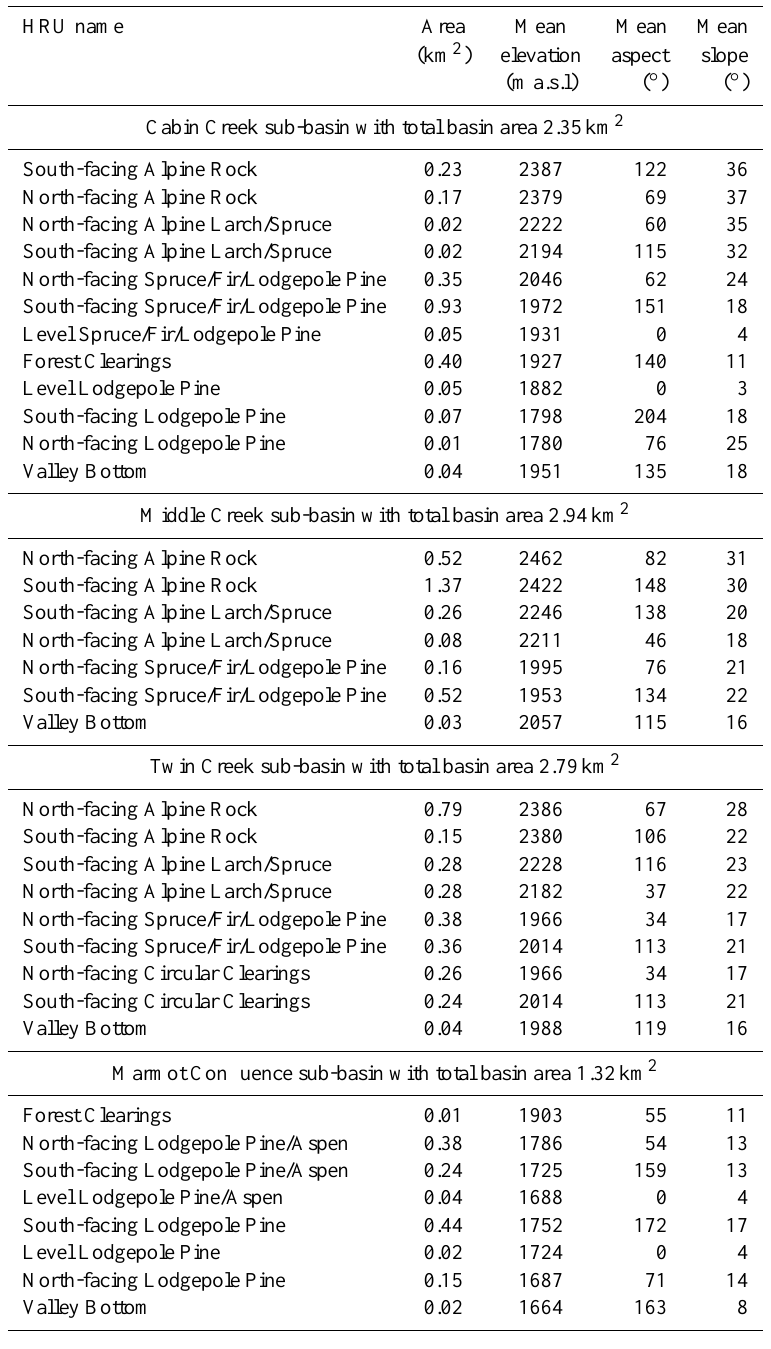
Table 1. Area and mean elevation, aspect, and slope for HRUs in sub-basins of the Marmot Creek Research Basin. Note that the aspect is in degree clockwise from